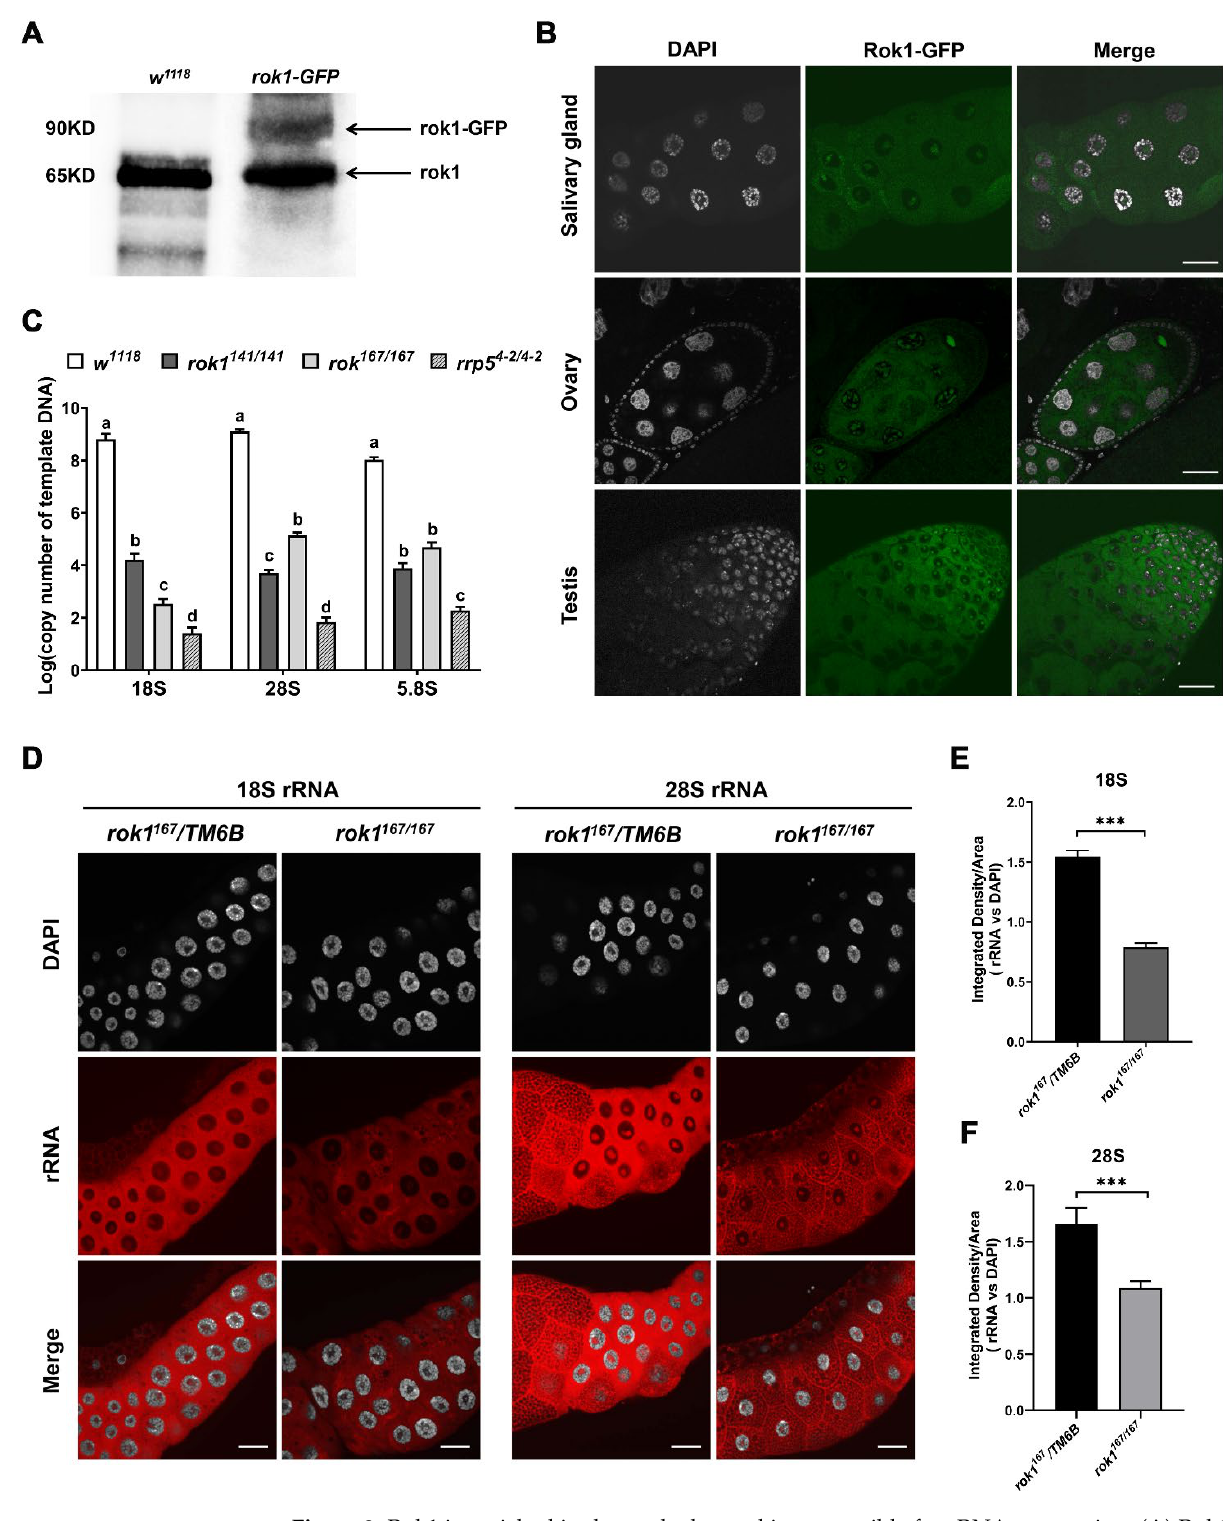
Figure 3. Rok1 is enriched in the nucleolus and is responsible for rRNA maturation. ( A ) Rok1 and Rok1-GFP levels were assayed by Western blotting. Total protein extracts (10 ug) from the embryos of w 1118 and rok1-GFP were loaded onto 10% SDS-PAGE gels. Arrows indicate the corresponding bands. ( B ) Overview of Rok1-GFP localization in the salivary gland, ovary, and testis. Salivary glands from third-instar larvae of w 1118 , ovaries, and testes from adult flies were dissected. Prominent Rok1 enrichment can be seen in a “chromatin-poor” region. Scale bar represents 40 μm. ( C ) The expression levels of mature rRNAs in rok1 and rrp5 mutants. Thirty second-instar larvae of w 1118 , rok1 141/141 , rok1 167/167 , and rrp5 4-2/4-2 were pooled as one sample. The initial copy numbers of 18S,